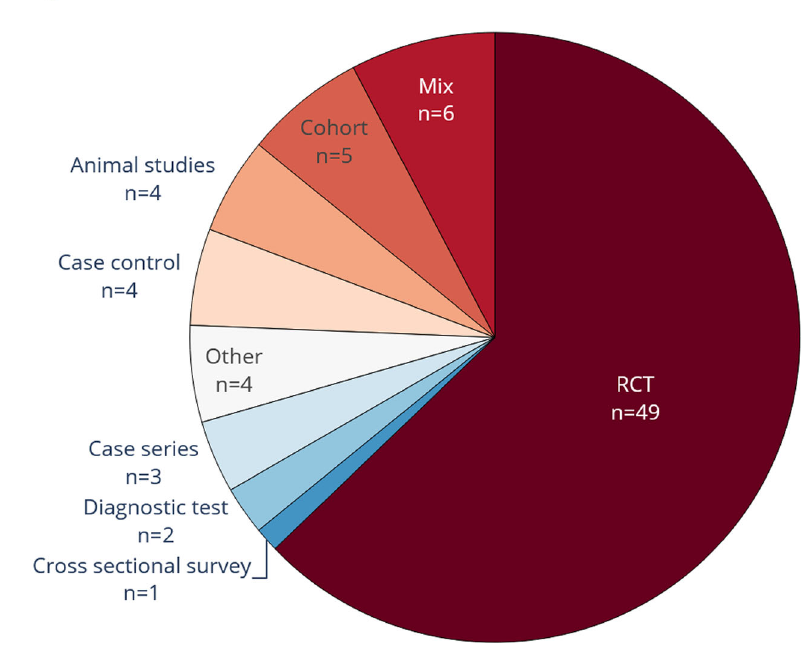
Figure 6. The study types from which data were extracted. Commonly, randomized controlled trials (RCT) text was at least one of the target text types used in the included